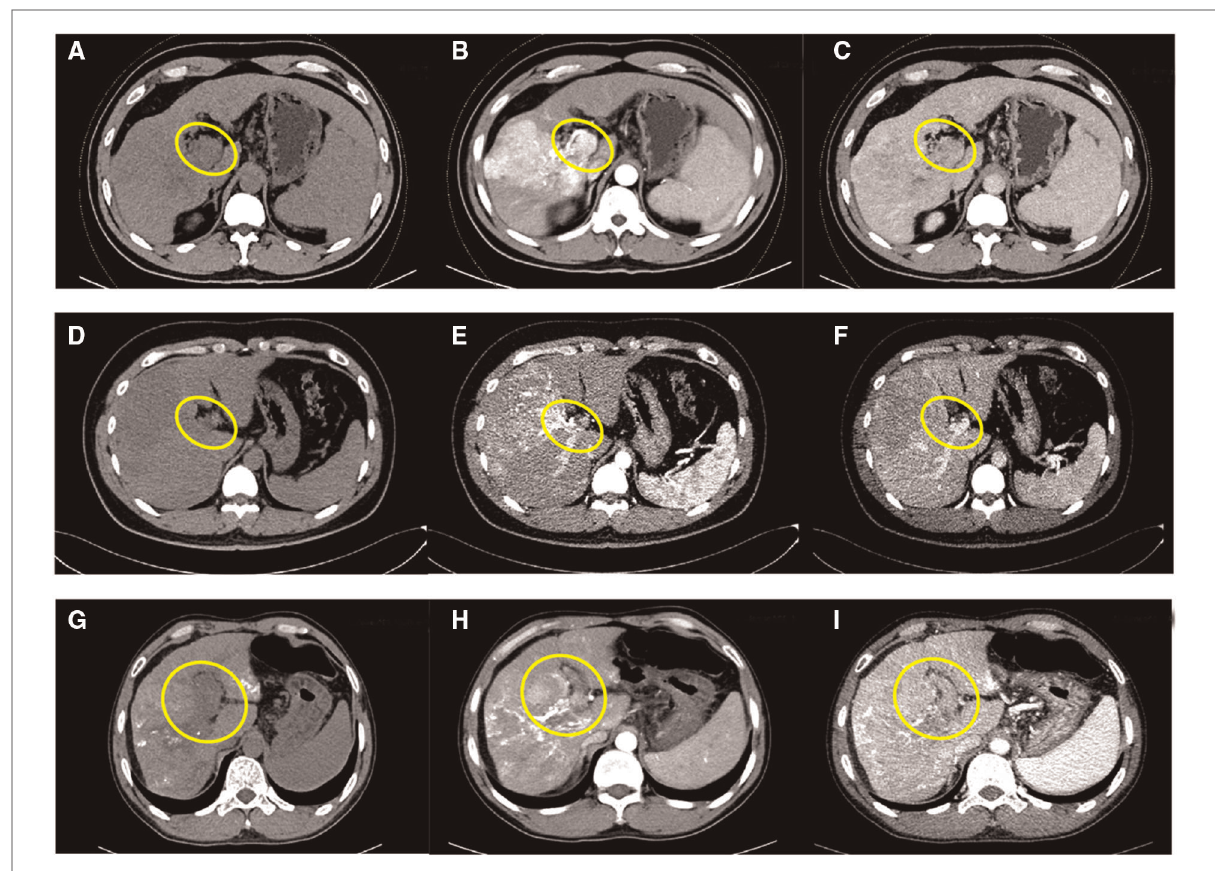
FIGURE 1 Preoperative CT images of case 1: unenhanced phase ( A ), arterial phase ( B ), and venous phase ( C ); preoperative CT images of case 2: unenhanced phase ( D ), arterial phase ( E ), and venous phase ( F ); preoperative CT images of case 3: unenhanced phase ( G ), arterial phase ( H ), and venous phase ( I ); inside the yellow circle is the portal vein tumor thrombus.